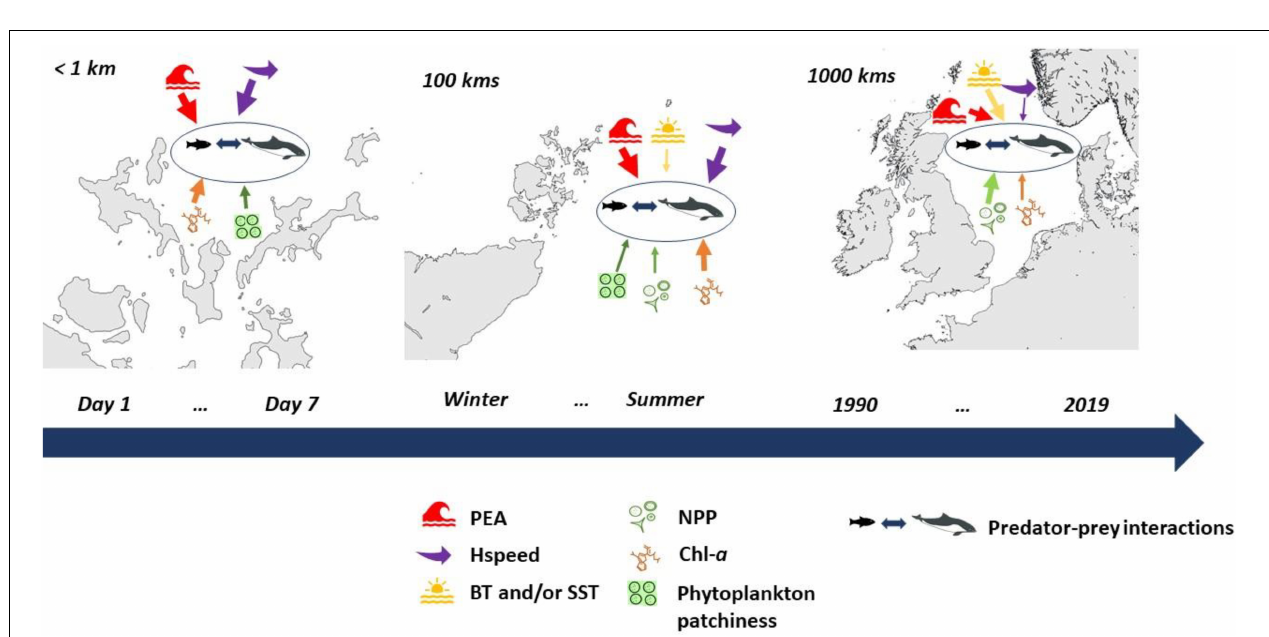
FIGURE 6 | Marine ecosystem modeling approaches for climate change and ORE developments and their overlap across spatial and temporal scales. The colored circles are used to represent which groups of models work best together across spatial and temporal scales, which was determined, based on all the reviewed literature for this study.